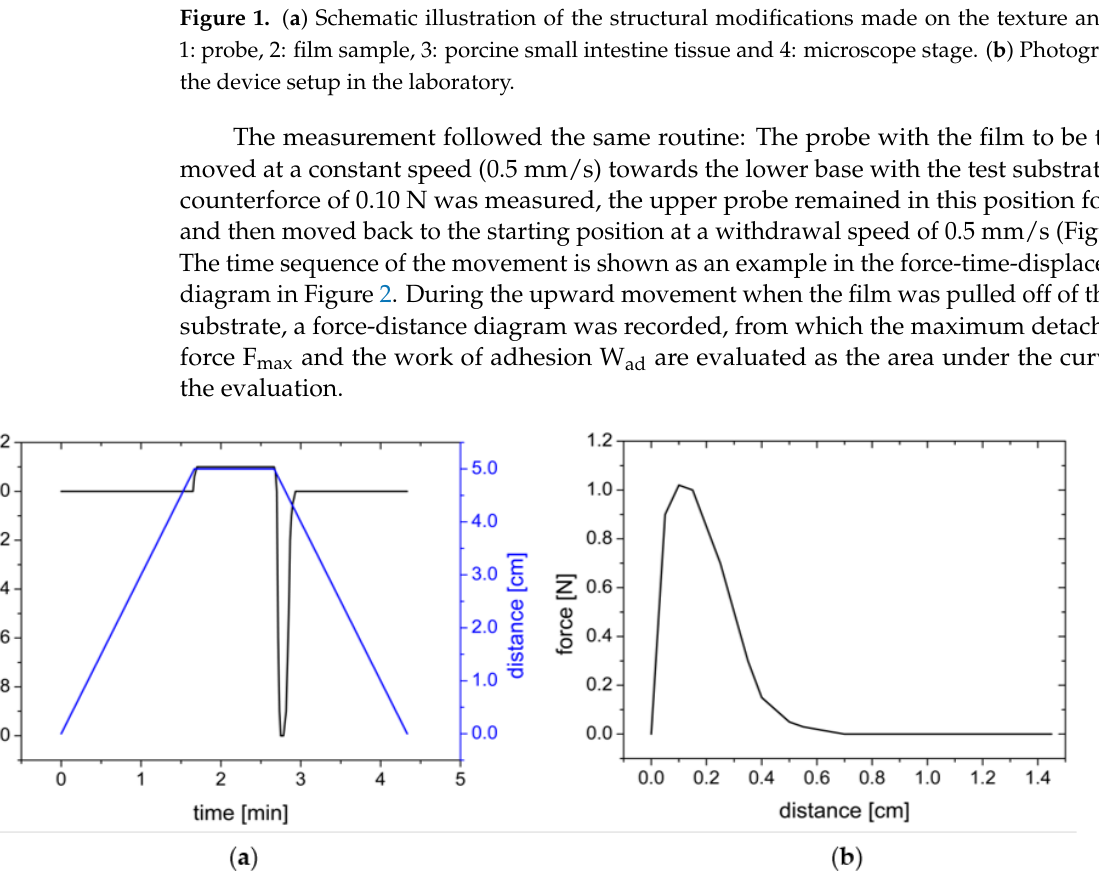
Figure 2. ( a ) Schematic force − time − distance diagram of the upper probe movement. ( b ) Resulting force distance diagram.